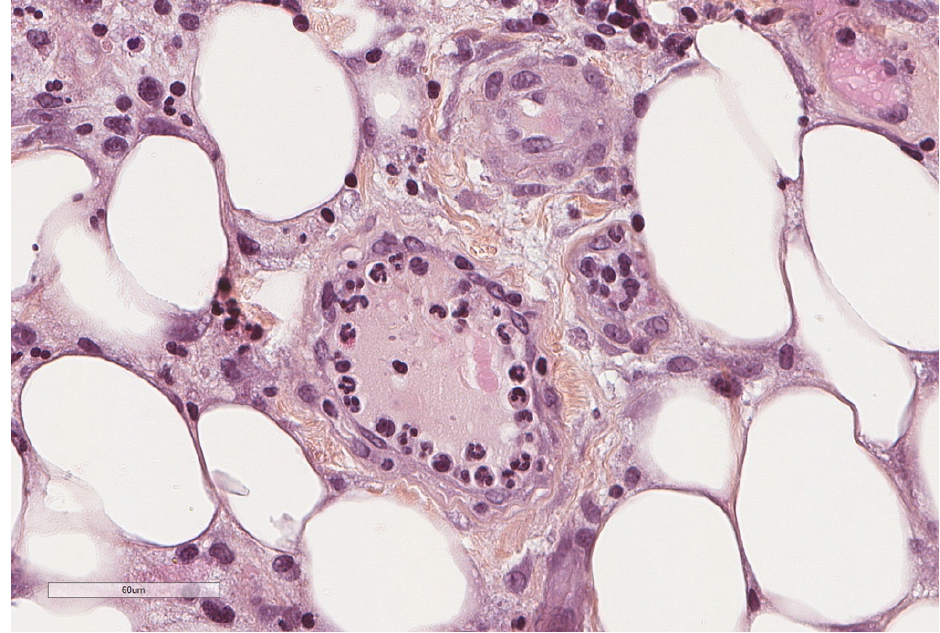
Figure 9. At this initial stage, margination, preceding diapedesis, of neutrophils inside blood vessels is seen. Hematoxylin, eosin, saffron staining (×400).